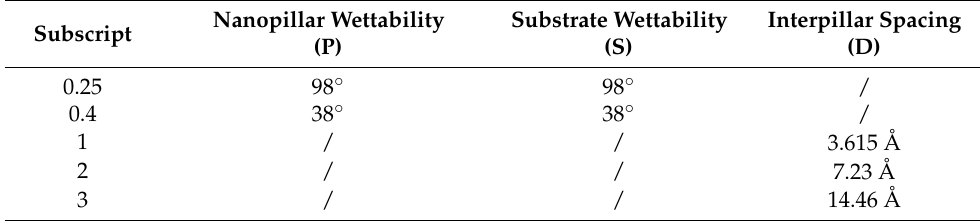
Table 1. Subscript notation for nanopillar wettability, substrate wettability, and interpillar spacing.